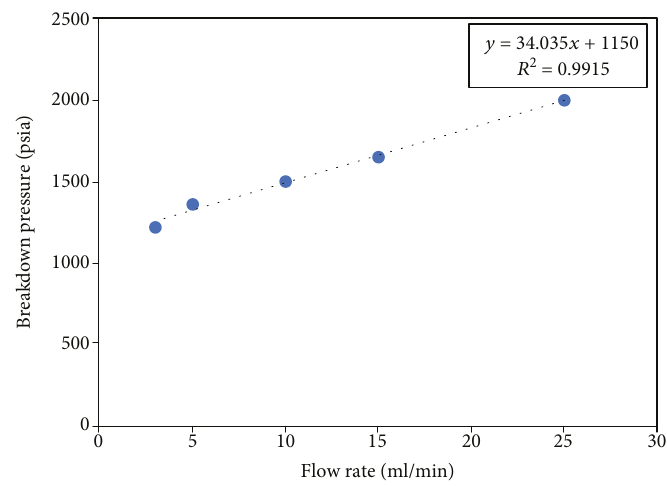
Figure 7: E ff ect of the fl ow rate on breakdown pressure.